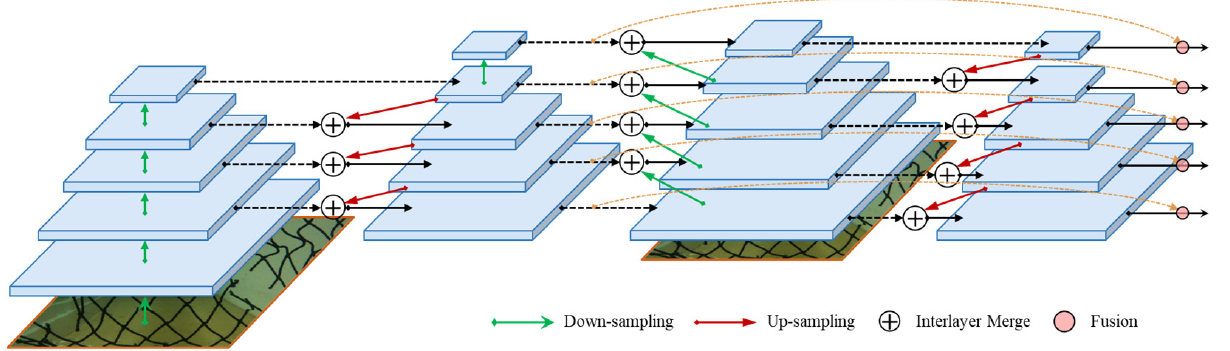
Figure 8. The architecture of RFP.